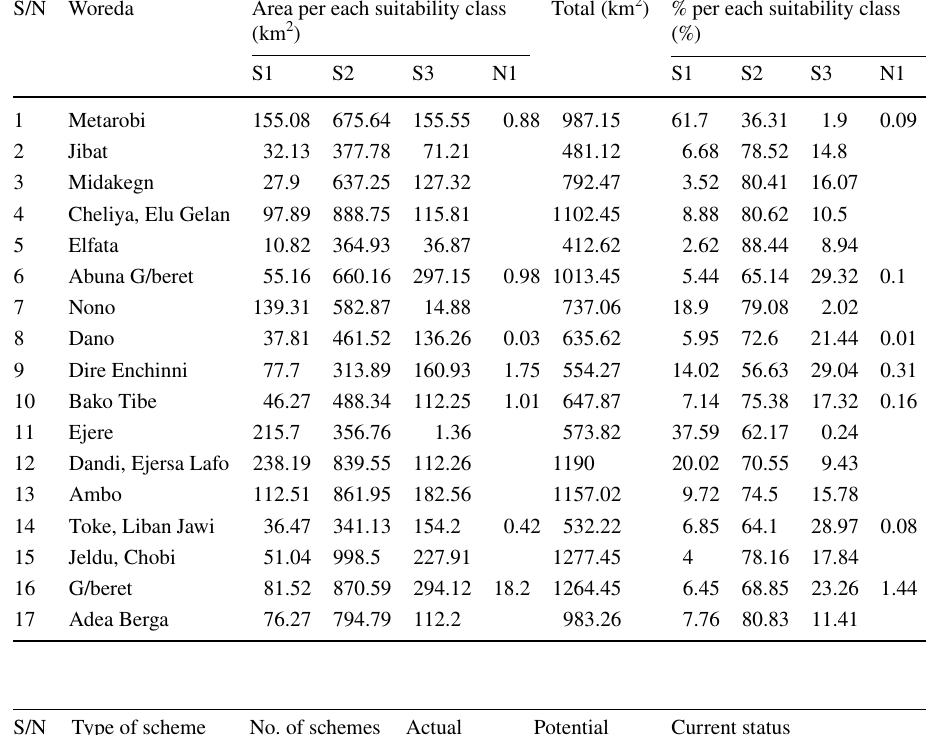
Table 11 The area and % age of land suitability classes in the woreda